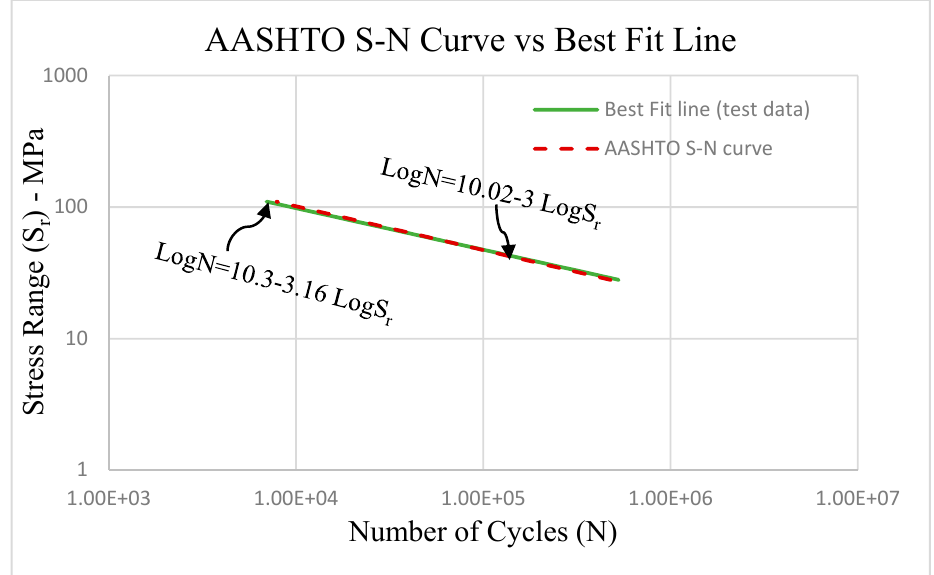
Figure 17. AASHTO S-N curve vs. best fit line.